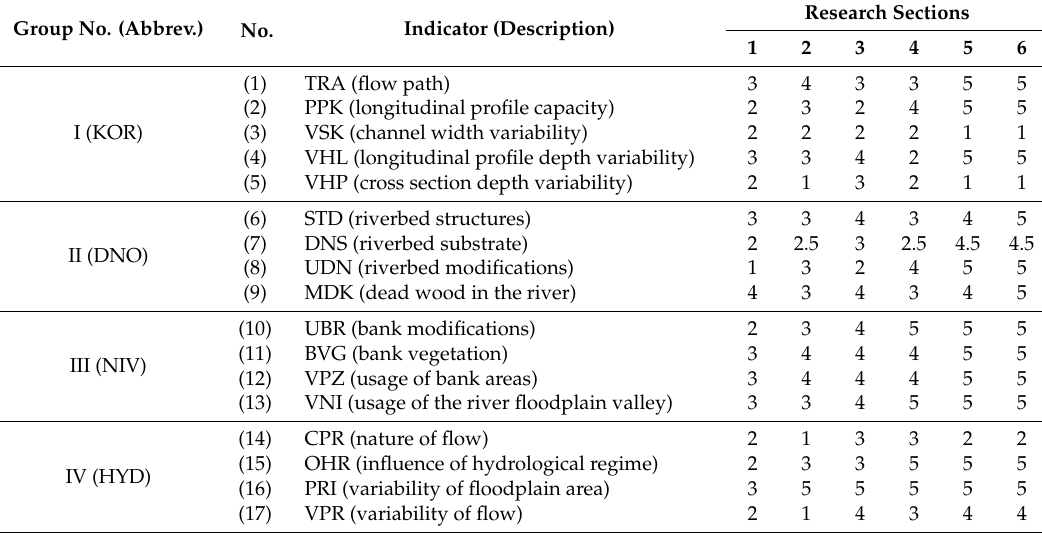
Table 10. Results of the hydromorphological status testing in the research sections under analysis based on the HEM method (Stage I—assessment of the indicators in groups). Group No. (Abbrev.)